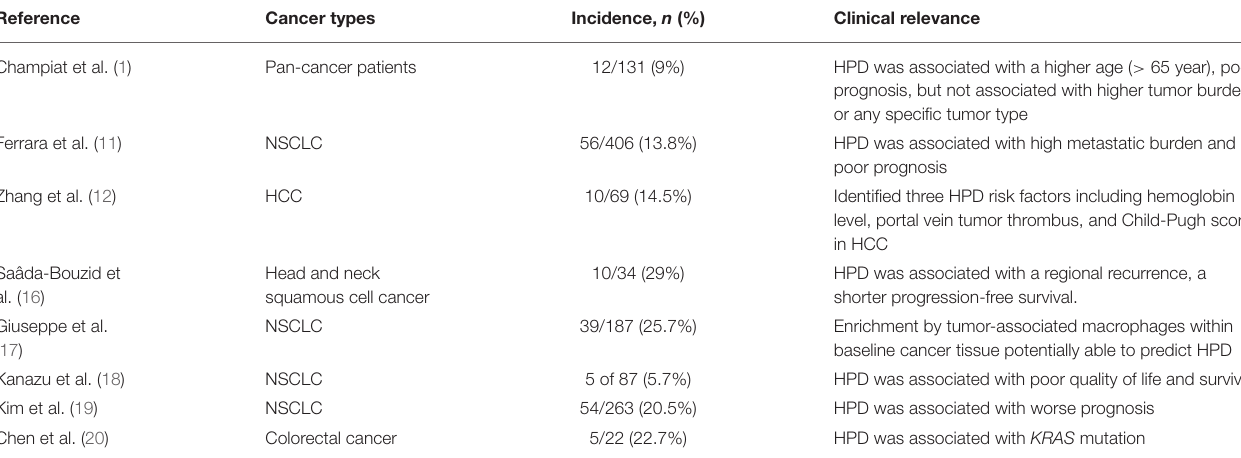
TABLE 1 | Representative case series studies of HPD in multiple cancer